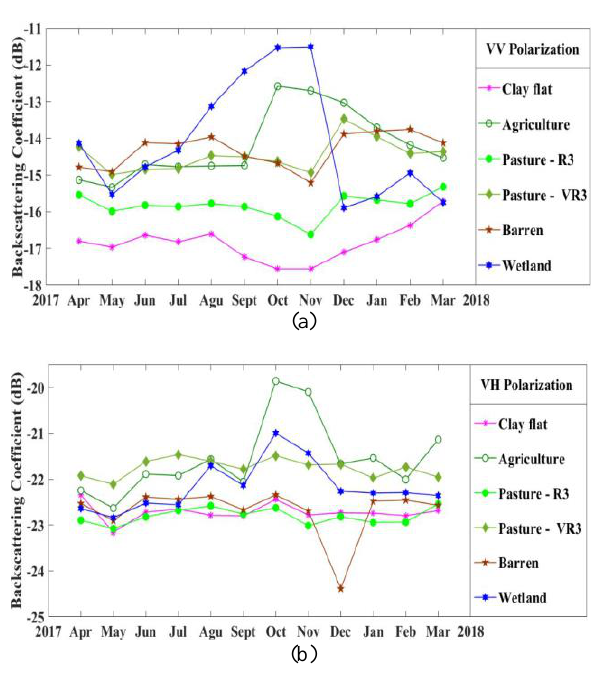
Figure 3. Backscattering Coefficients obtained from (a) VV and (b) VH polarizations between April 2017 and March 2018.